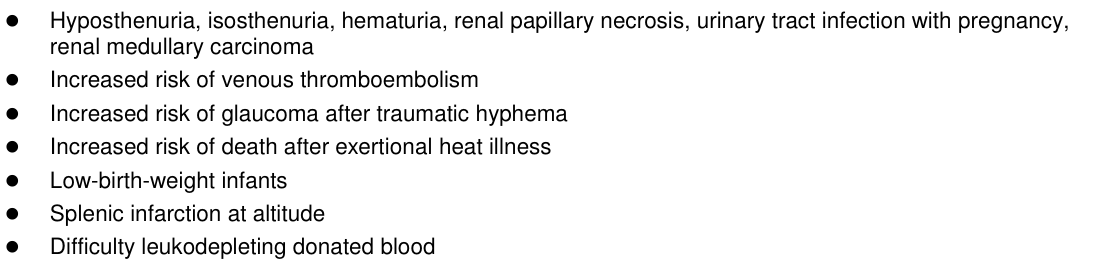
Complications of Sickle Cell